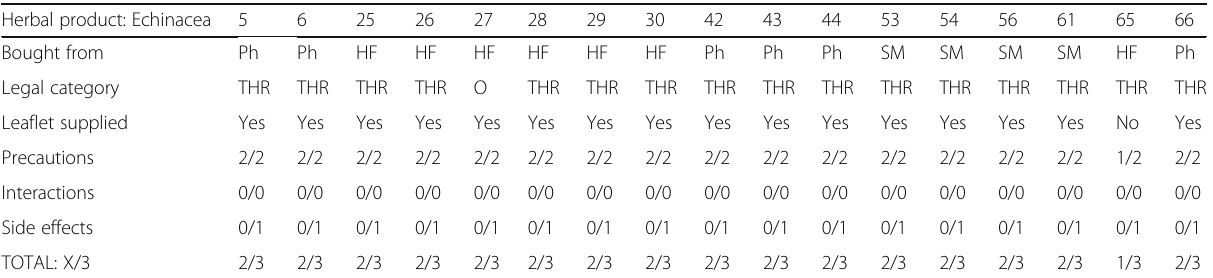
Table 5 Echinacea Herbal product: Echinacea